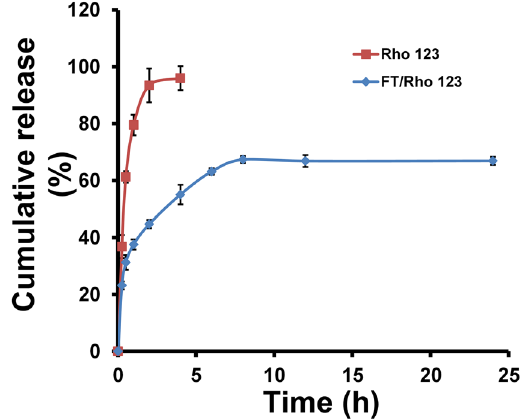
Figure 3. In vitro release of Rho 123-loaded FT mixed micelles. Free Rho123 dissolved in methanol was used as control. Each point represents mean ± SD (n =